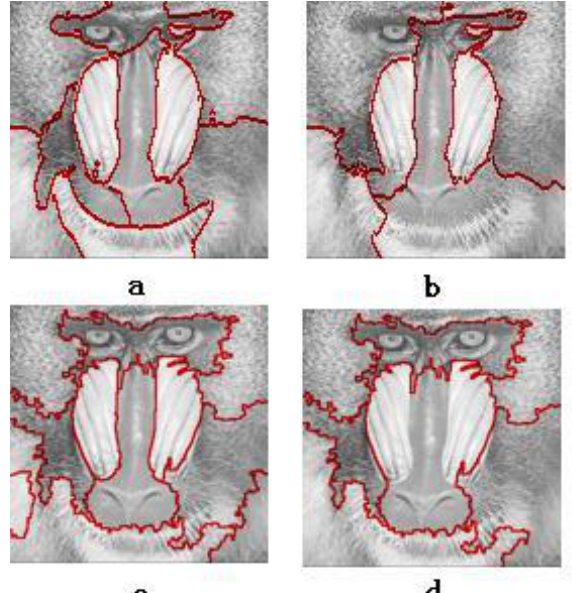
Fig 12. The comparison of segmentation of „Baboon‟ between Normalize Cut (a, b) algorithm and our method (c, d). Figure a, c are 10 regions while b, d are 6 regions.